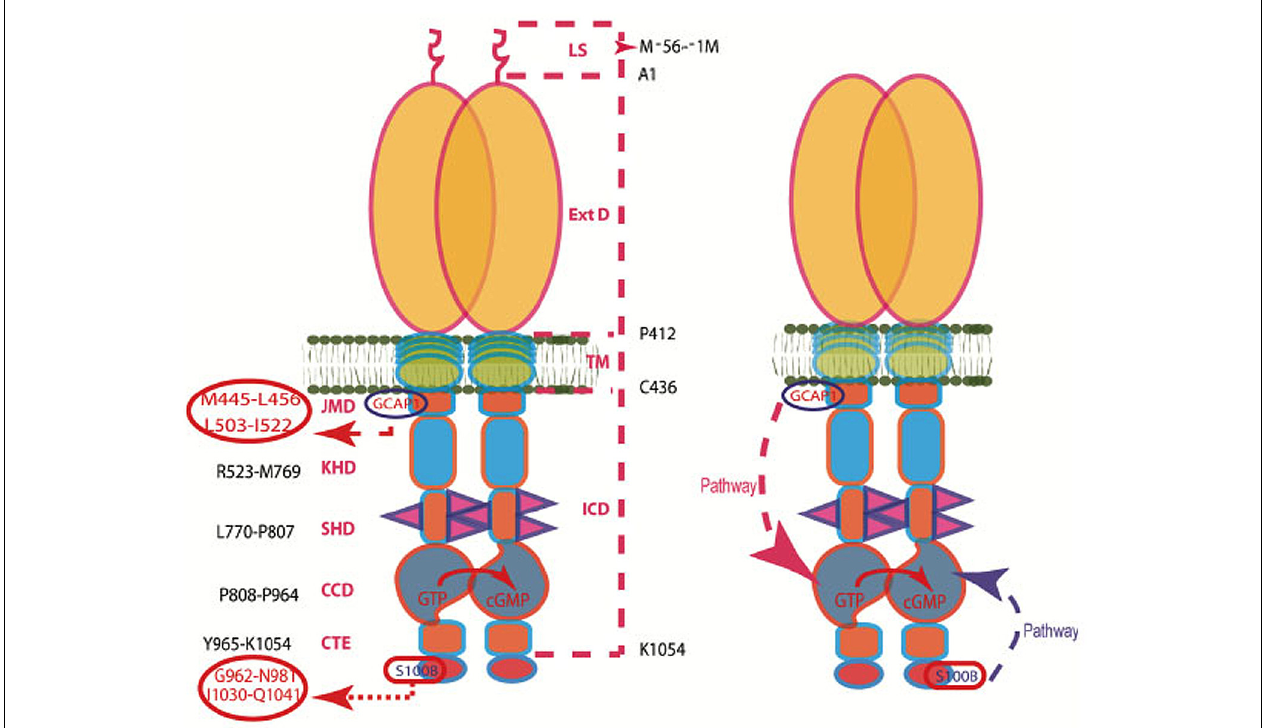
FIGURE 2 |The modular nature of ROS-GC1. Left Panel . The dashed lines on the right show the domain boundaries: LS, leader sequence (note: the leader sequence is absent from the mature protein shown in the right panel); ExtD, extracellular domain; TM, transmembrane domain; ICD, intracellular domain. The designated names and the amino acid residues constituting their boundaries are indicated on the left: JMD, juxtamembrane domain housing the indicated GCAP1-binding site; KHD, kinase homology domain; SHD, signaling helix domain; CCD, core catalytic domain; CTE, C-terminal extension housing the S100B-binding site. It is noteworthy that the ICD contains all of the functional domains and that